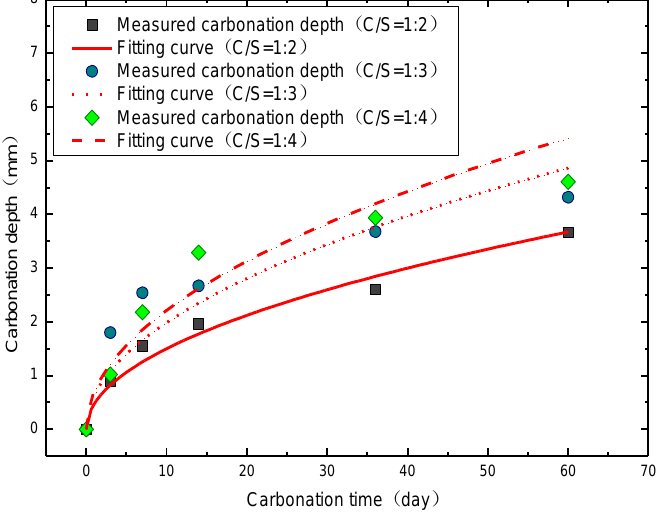
Figure 8. The experimental result of carbonation depth for mortars with different cement/sand ratio (1:2,1:3,1:4) and its fitting